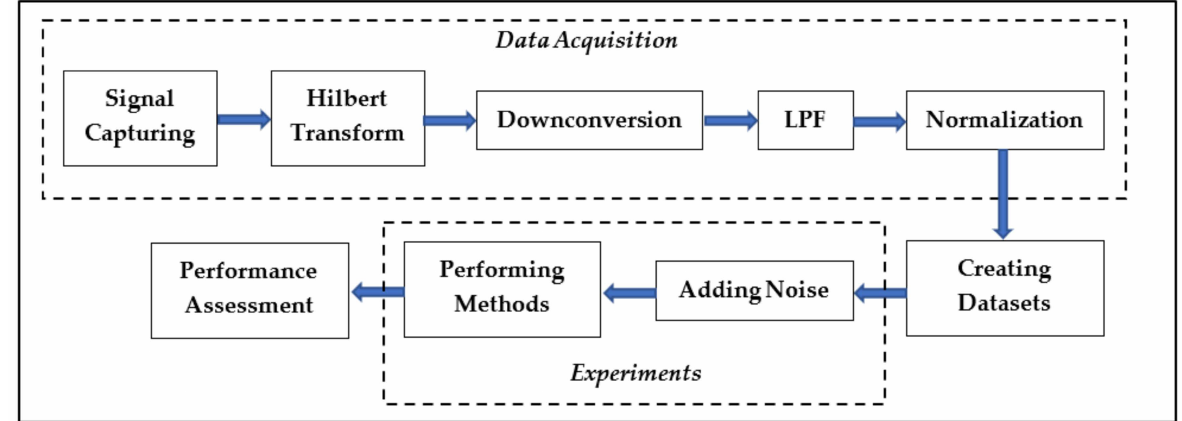
Figure 1. Overall process for the presented study.